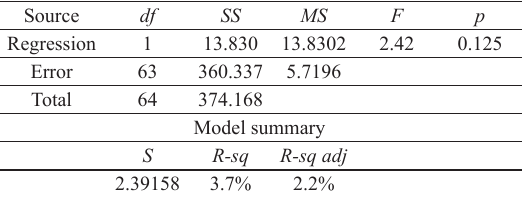
Figure 12. Plotting of the total results for Radial and 45-A Orientation Tension Strengths. Table 6. Analysis of Variance: Radial Tension versus Tangential Tension Strengths.